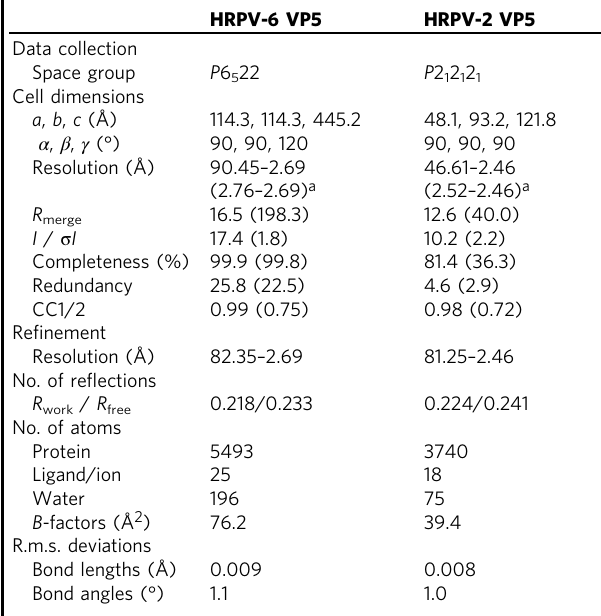
Table 1 X-ray data collection and re fi nement